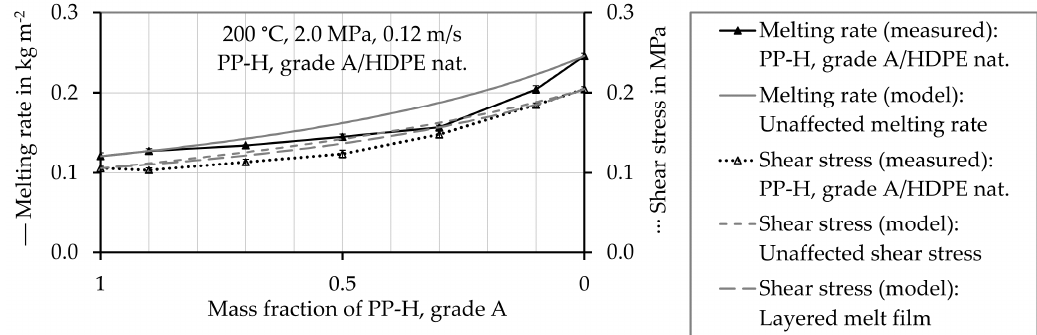
Figure 8. Measured and estimated values of the melting rate and shear stress of the mixture of PP-H, grade A, and HDPE at a temperature of 200 °C.